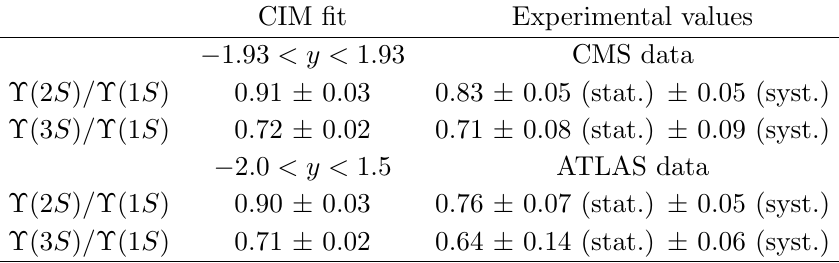
at 5.02 TeV. p Pb